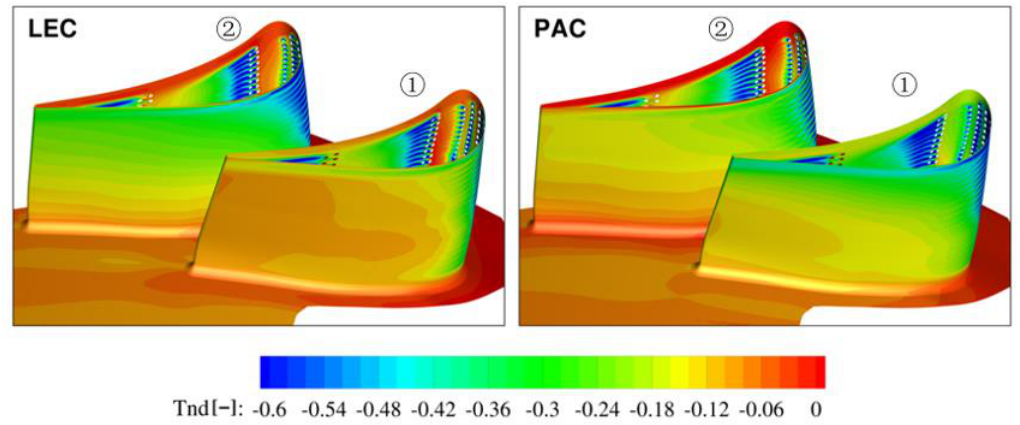
Figure 16. Non-dimensional temperature on the NGV suction side.